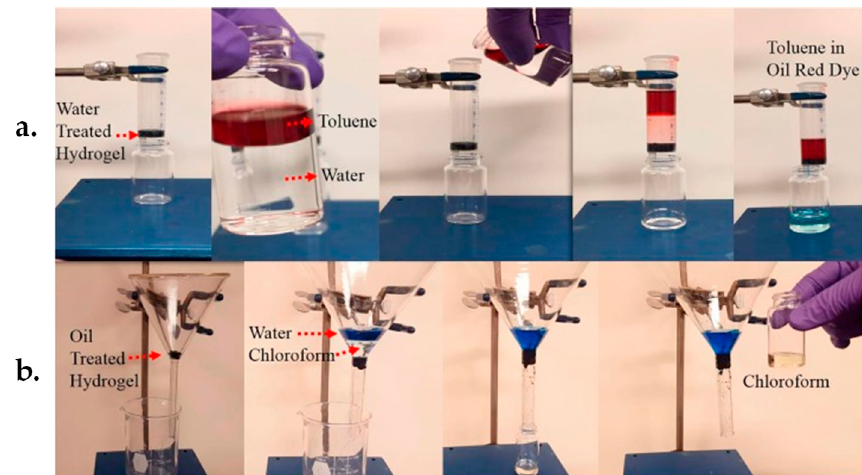
Figure 7. Oil-water separation employing ( a ) LA/F/rGO hydrogel pretreated with water for oil (toluene) separation from water, and ( b ) LA/F/rGO hydrogel pretreated with oil for water separation from oil (chloroform). Reprinted with the permission from ref. Reproduced from [191], with permission from Elsevier, 2018.